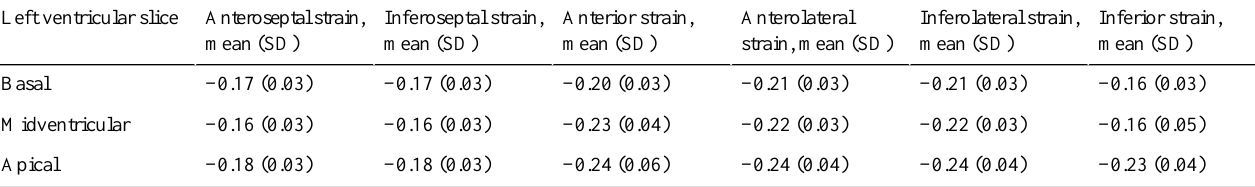
Table 2. End-systolic circumferential strain in healthy left ventricular myocardium from literature.